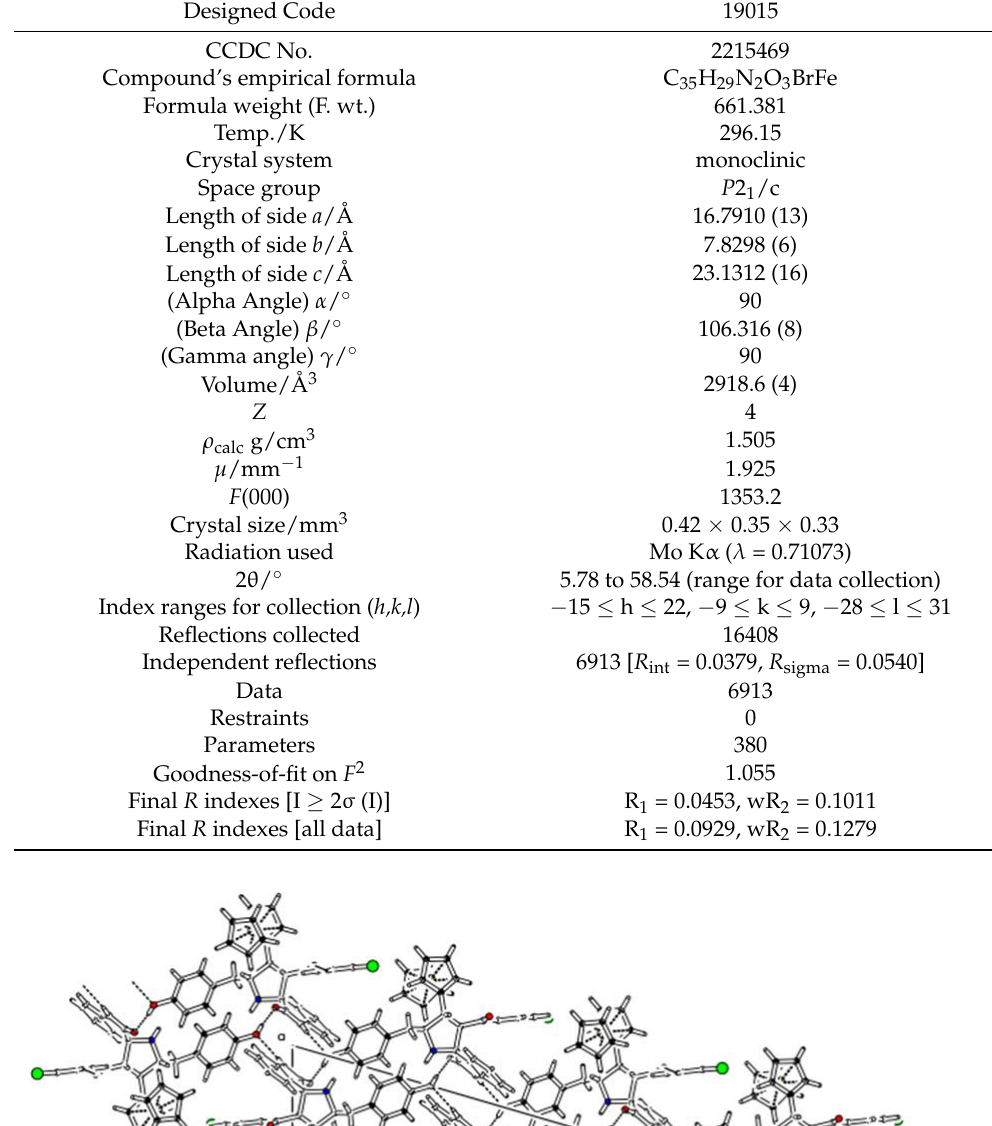
Table 5. Structural unique crystal data and refinement parameters for 3a .